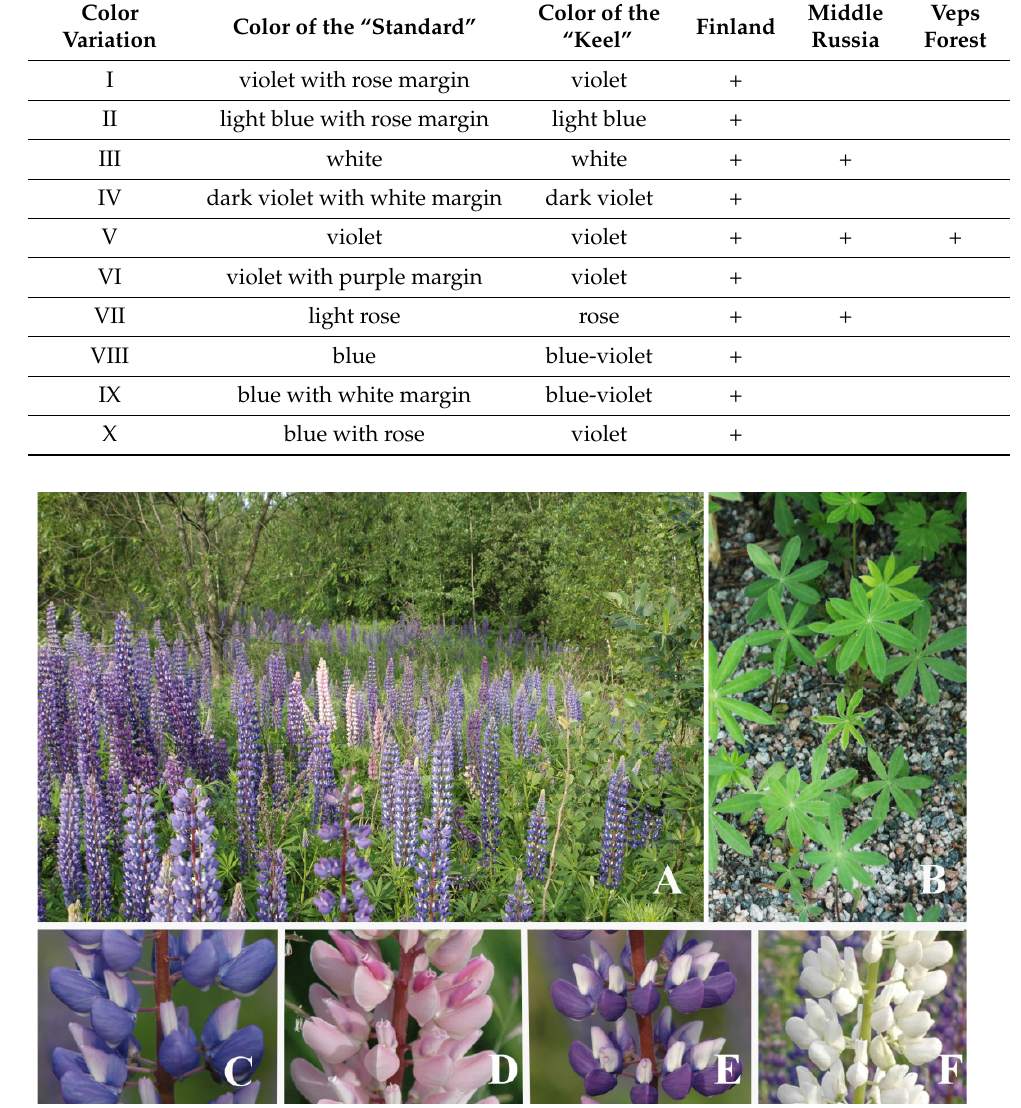
Figure 3. Invasion of Lupinus polyphyllus in the natural plant communities in Finland. ( A ) Invasive population, 2014, Alberga; ( B ) Mass self-seeding; ( C – F ) Color variability of the corolla: ( C ) violet, ( D ) light rose, ( E ) purple, and ( F ) white.